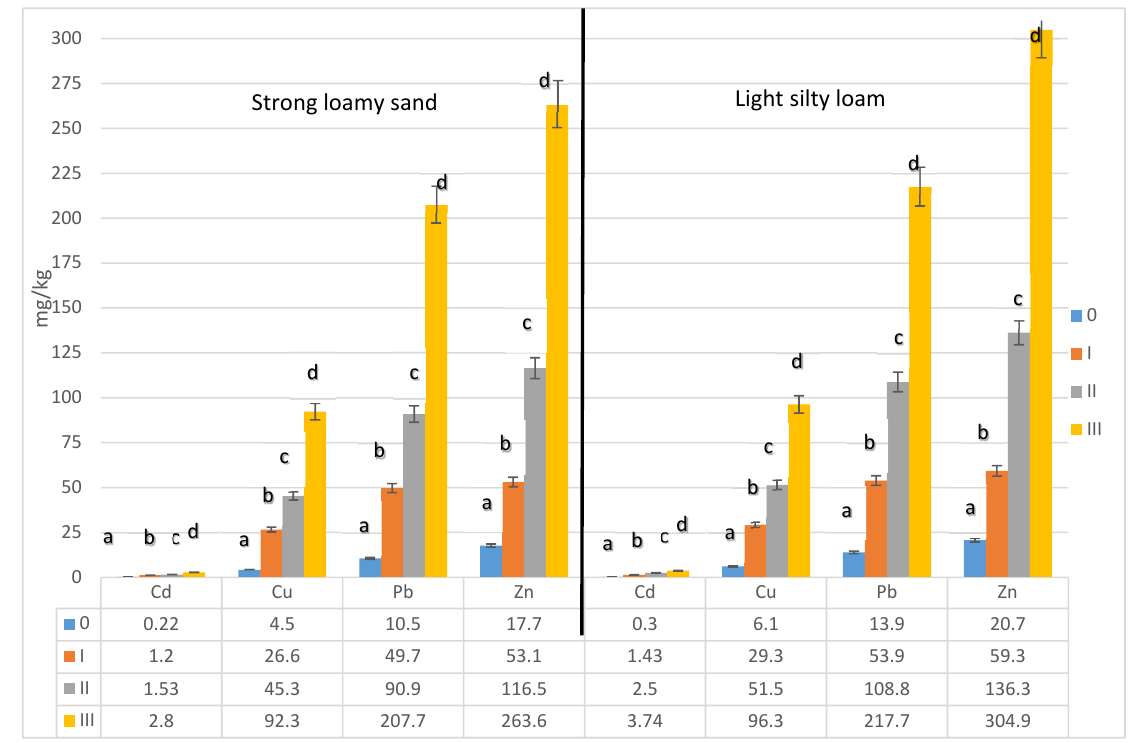
Figure 1. Mean concentrations of Zn, Pb, Cd and Cu in the topsoil layer (0–30 cm) determined in royal water. a, b, c, d—treatments with the same letter are not significantly different ( p ≤ 0.05).